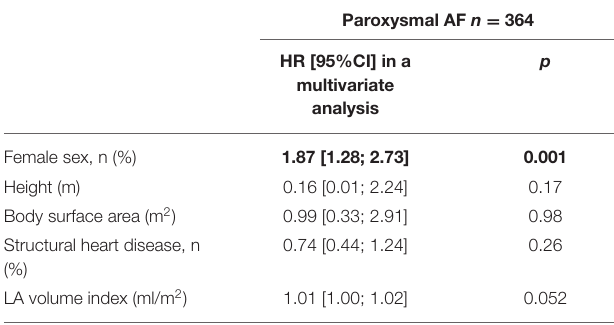
TABLE 3 | Sex differences in outcomes after an index cryo-PVI for paroxysmal AF. Paroxysmal AF at the time of cryo-PVI